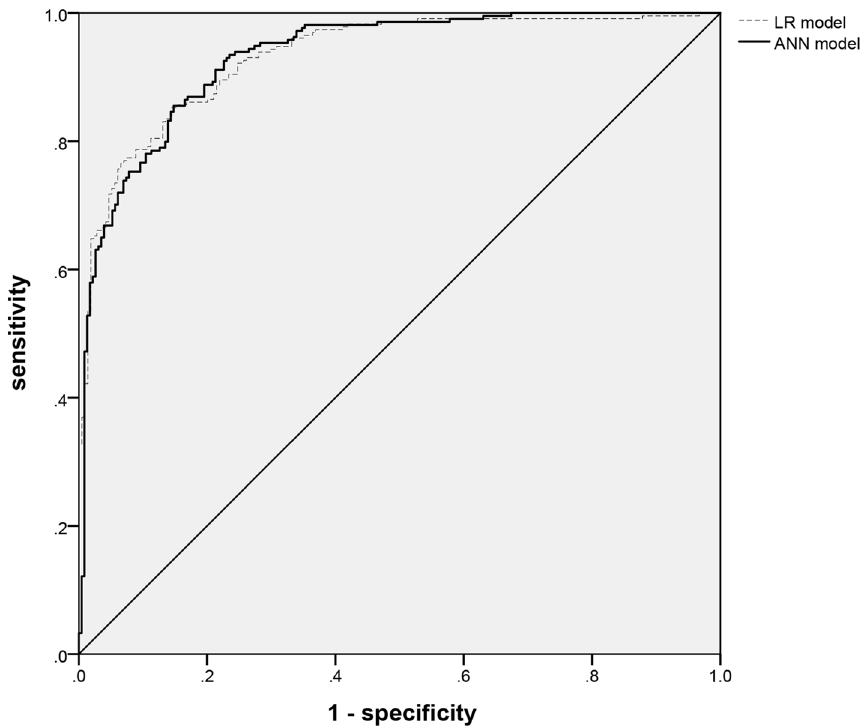
Figure 3. ROC curves for the ANN model to predict the efficacy of folic acid therapy to HHcy in the development set.